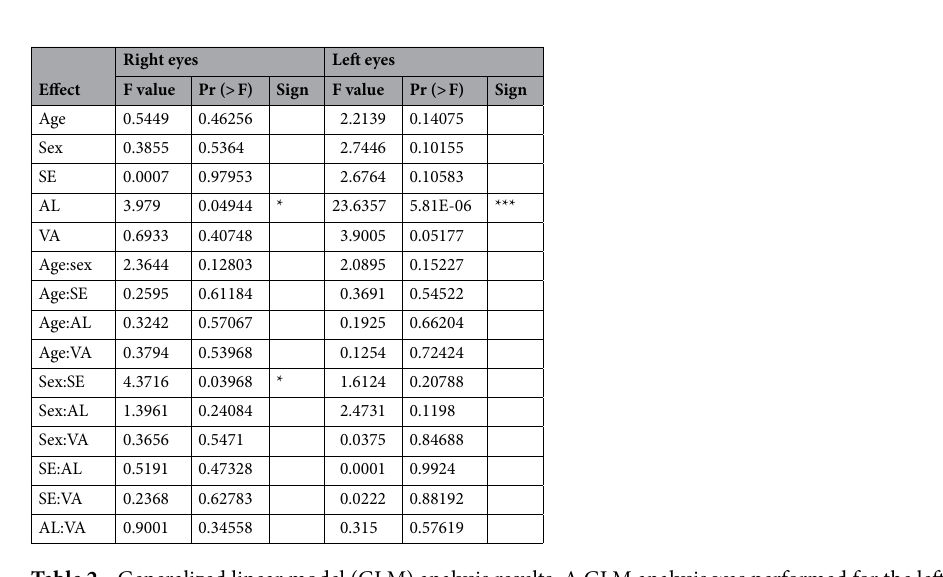
Right vs. left eyes. A paired two-sided t -test on the OCTA vessel surface area performed to compare the left and right eyes yielded a p-value of 0.76 (value of t -test statistic, 0.306). There was no significant difference in the OCTA retinal surface area between the left and right eyes. Age, SE, and VA.